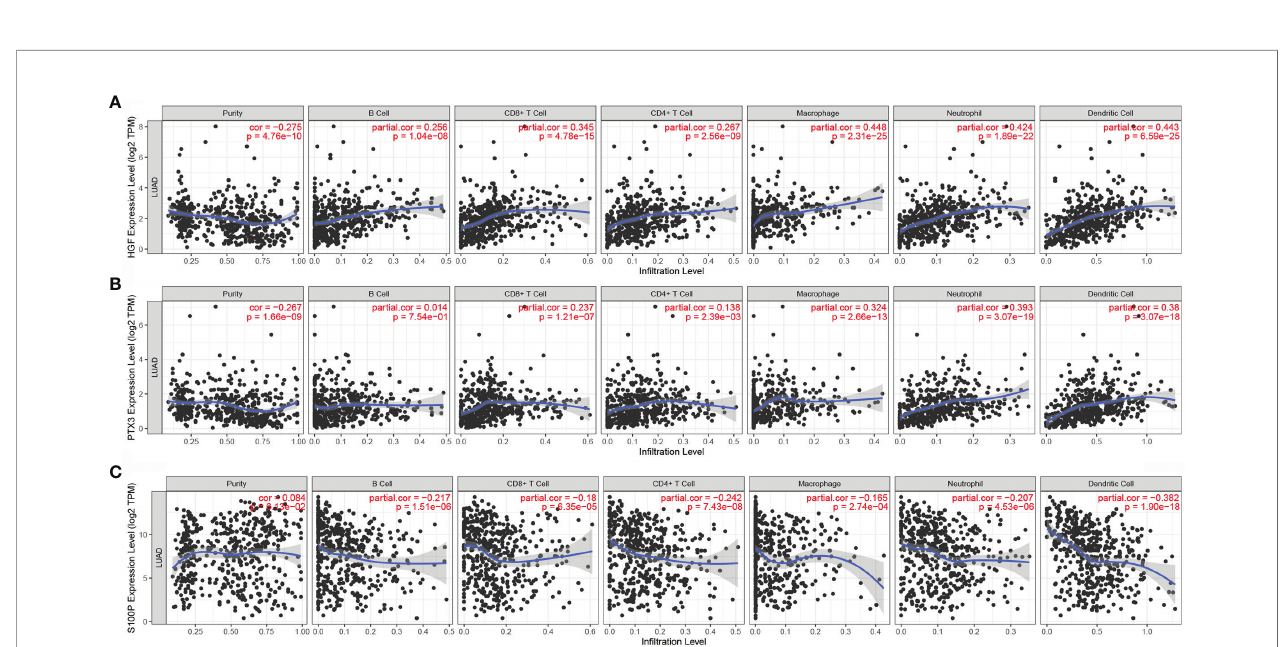
FIGURE 8 | Correlation of HGF, PTX3, and S100P with immune cell in fi ltration. (A) Correlation between HGF and immune cell in fi ltration; (B) Correlation between PTX3 and immune cell in fi ltration; (C) Correlation between S100P and immune cell in fi